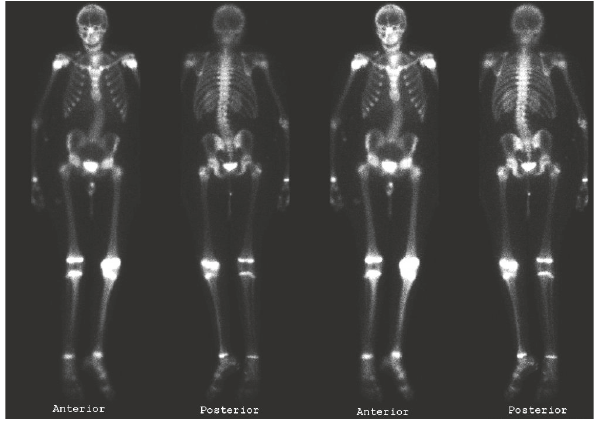
Figure 3: Three-phase bone scintigraphy, August 2009. Increased uptake in the distal left femur on delayed images.